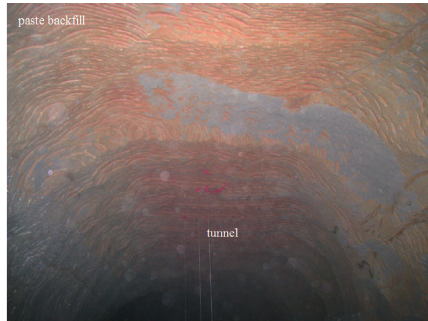
Figure 8: Completed tunnel in paste backfill.